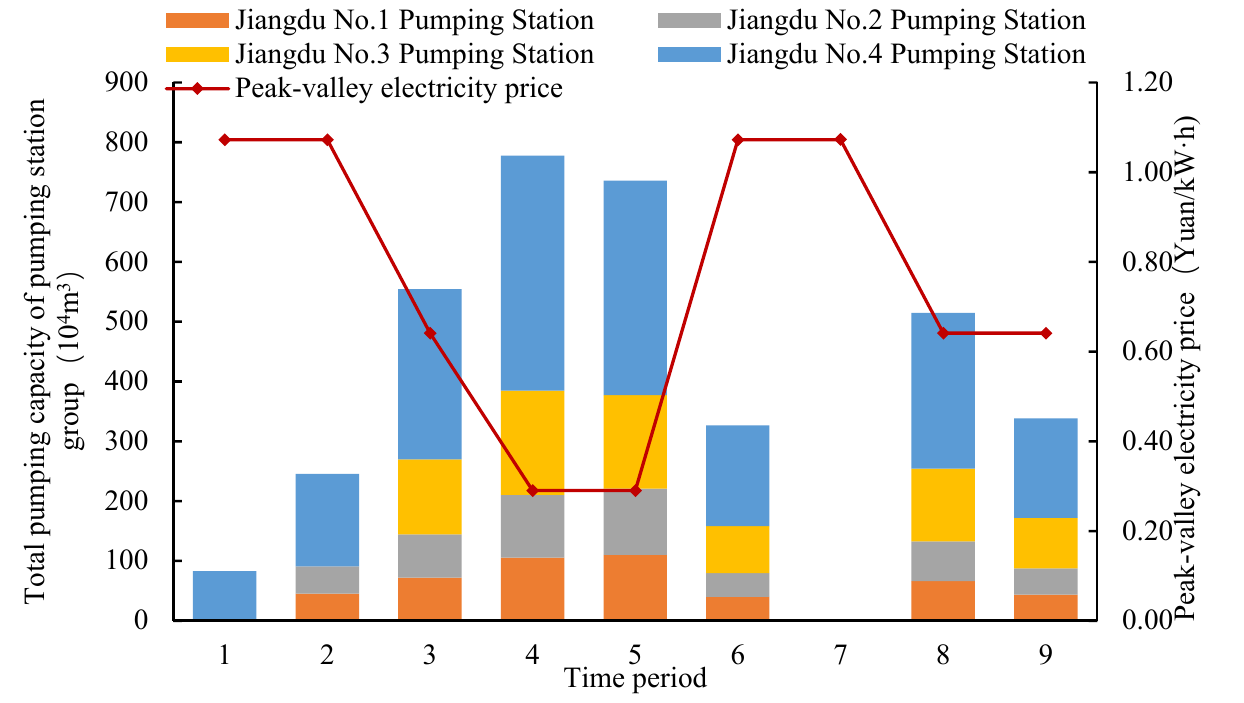
Figure 6. Water extraction of a parallel pumping station and corresponding peak–valley electricity price in each divided time period. Table 6. Flow unevenness of each pumping station in time periods 3, 4 and 5. Name of Pumping